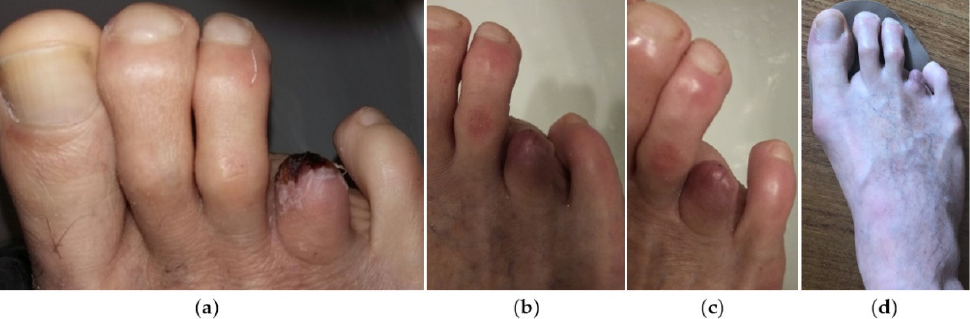
Figure 3. Clinical images of the right forefoot after digital amputation during post-operative period ( a – c ) and at the time of medical legal assessment ( d ).